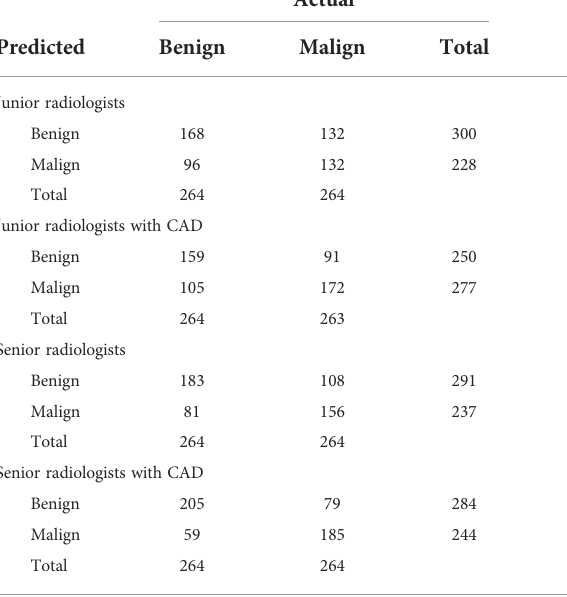
TABLE 4 Confusion matrices between radiologists of different level on the balanced data set.